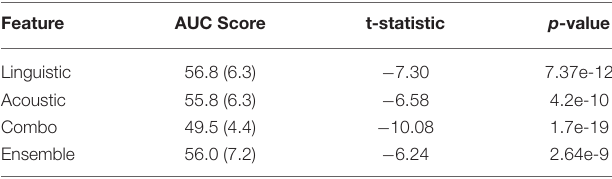
TABLE 5 | Comparisons of behavioral marker performances on 100 subtopic-stratified shuffle splits using structured